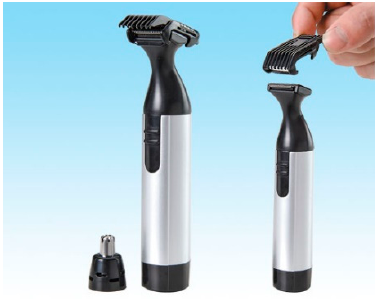
Figure 7. Wet/dry 2-in-1 men’s trimmer for men produced by the case company.